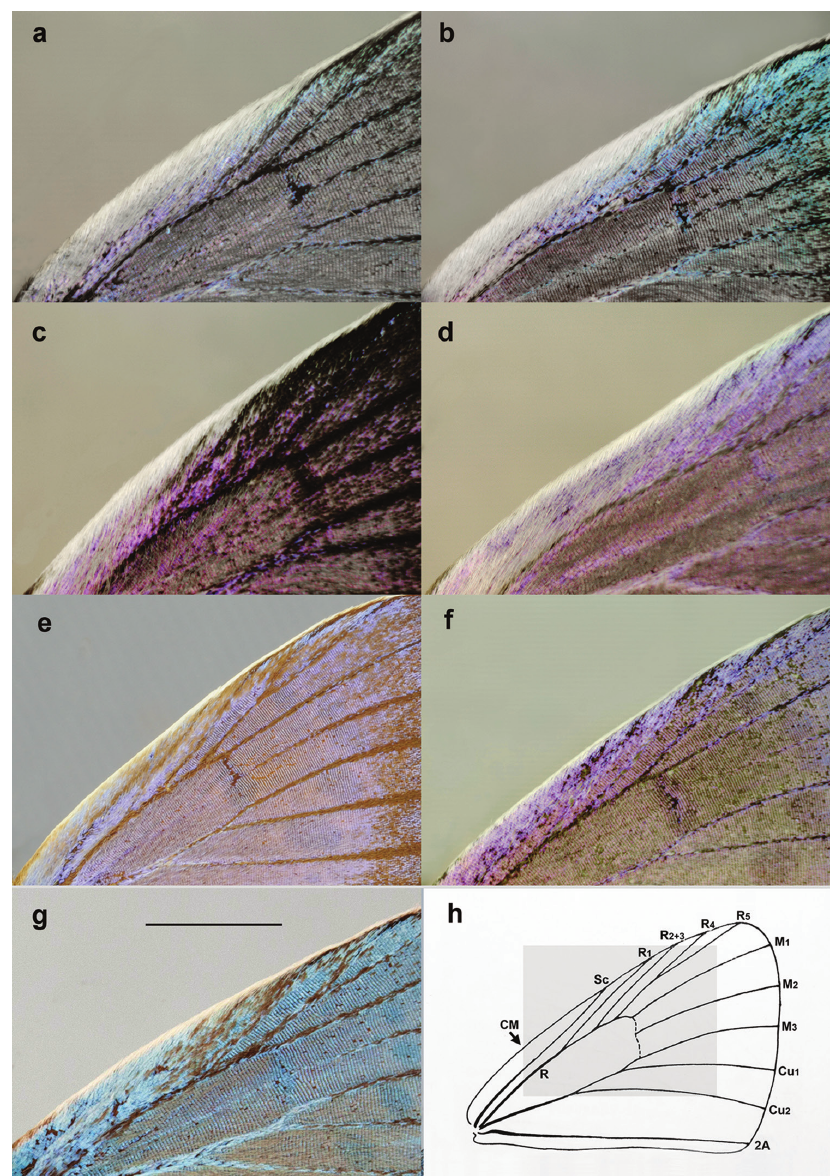
Figure 10. Pubescence of the anterior part of the forewing upper surface. a, b, c, d the anterior part of the forewing upper surface possesses a strong white pubescence in the area bordered by the costal margin (CM) and the veins R and R , i.e. this area is densely covered with relatively long white hairs 2+3 ( a P. aserbeidschanus b P. ninae , c P. arasbarani neglectus d P. australorossicus ) e, f the white pubescence of the anterior part of the forewing upper surface is strongly reduced and limited to the only costal margin, the white hairs are short ( e P. ciscaucasicus f P. shamil ) g the white pubescence of the anterior part of the forewing upper surface is reduced, not dense ( P. damonides ) h schematic picture showing the venation of the forewing in Polyommatus and the photographed area (shaded). Bar = 3